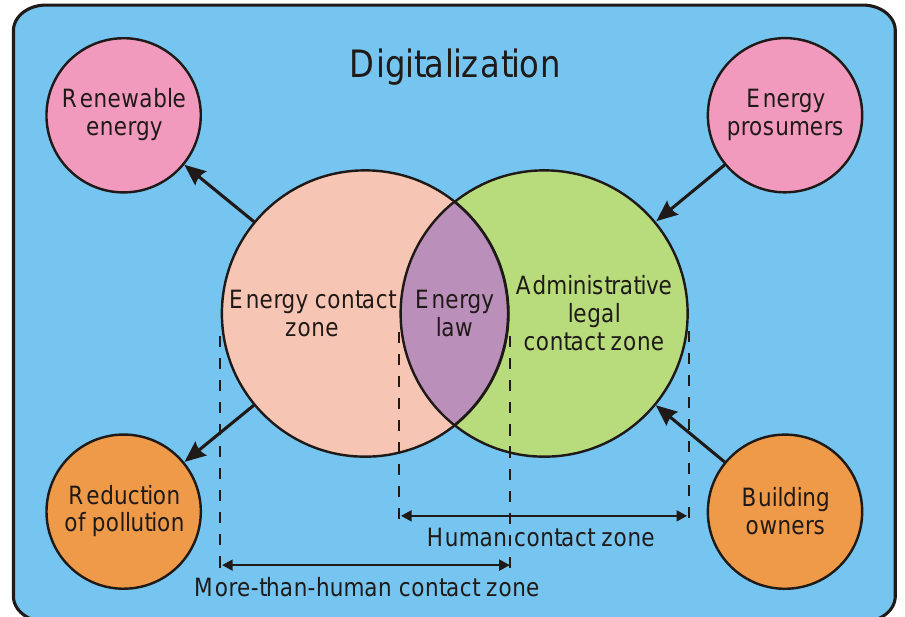
Figure 2. Types of contact zones in the energy transition.